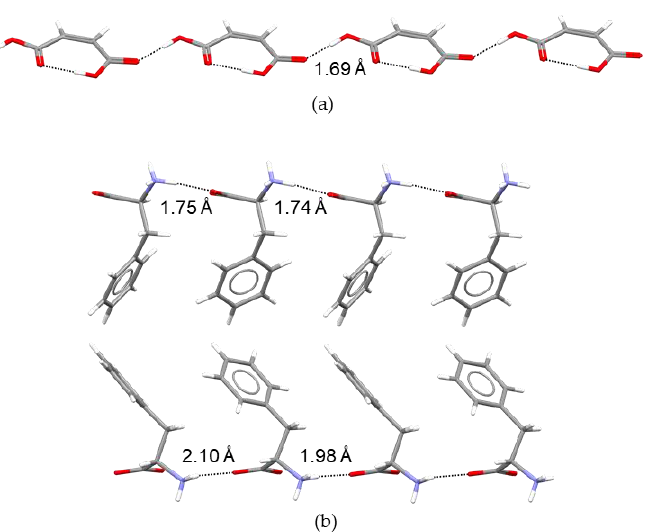
( 10 ) chains (10) C 1 2